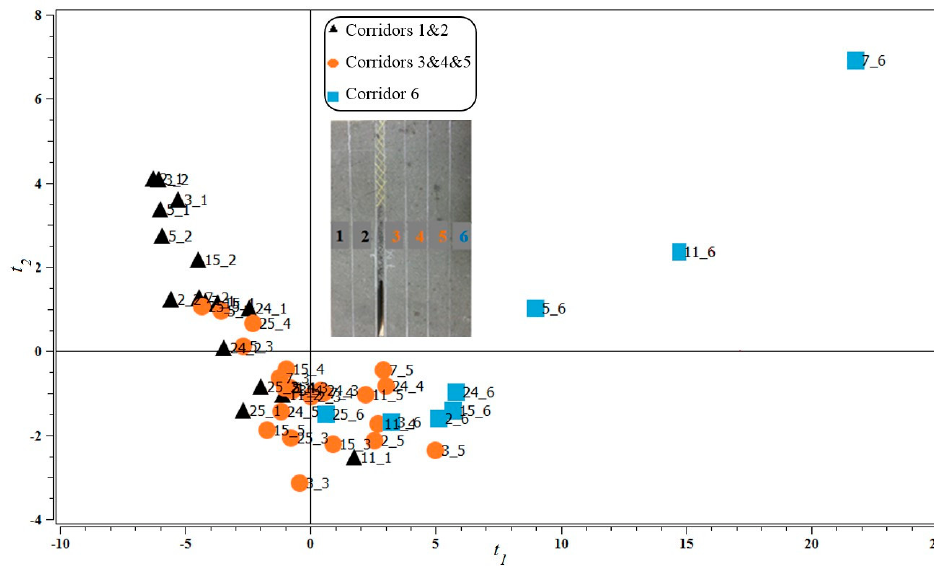
Figure 6. The t 1 – t 2 score plot of the principal component analysis (PCA) model built on acousto‐ultrasonic (AU) signal attenuation features.